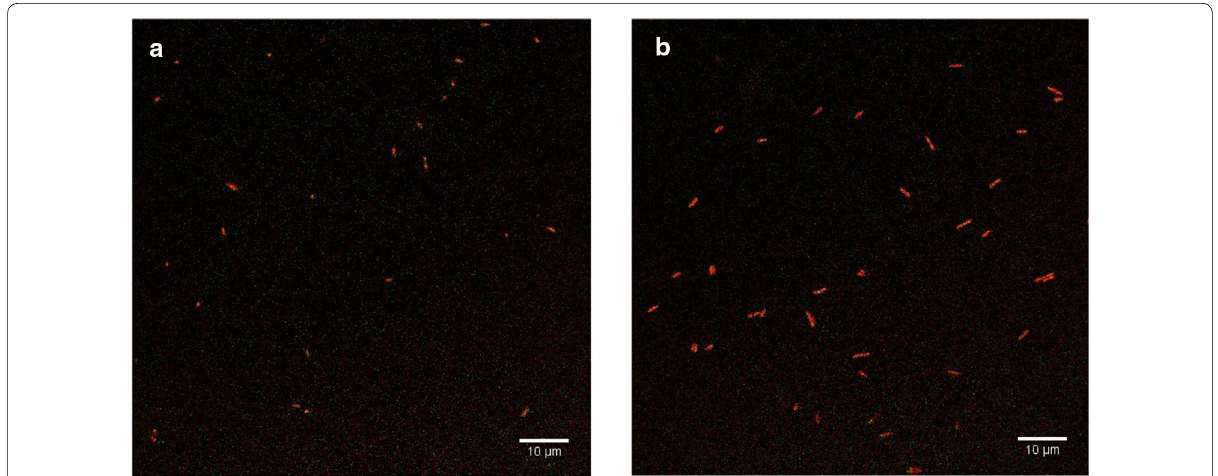
Fig. 3 L innocua ( a ), P. fluorescens ( b ) after 4 h enrichment in TSB and 30-min infection with bacteriophage